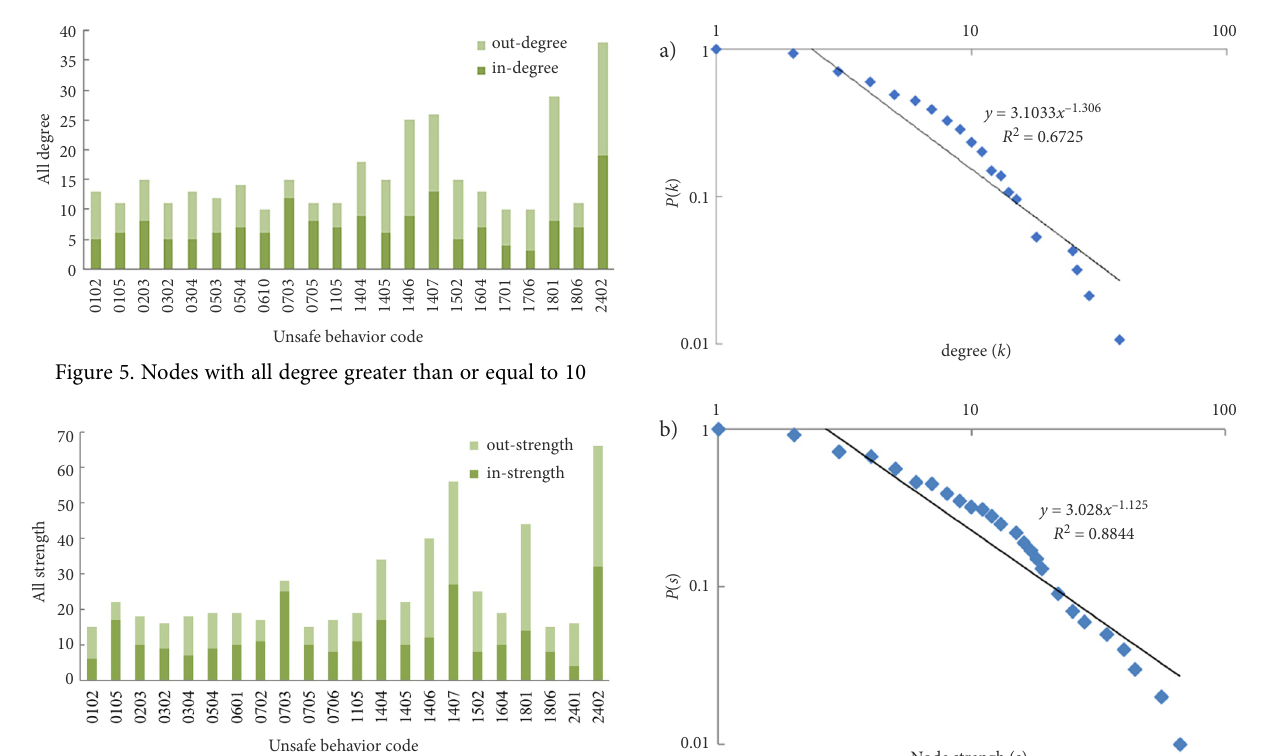
Figure 7. Distributions: a – the cumulative degree distribution; b – the cumulative node strength